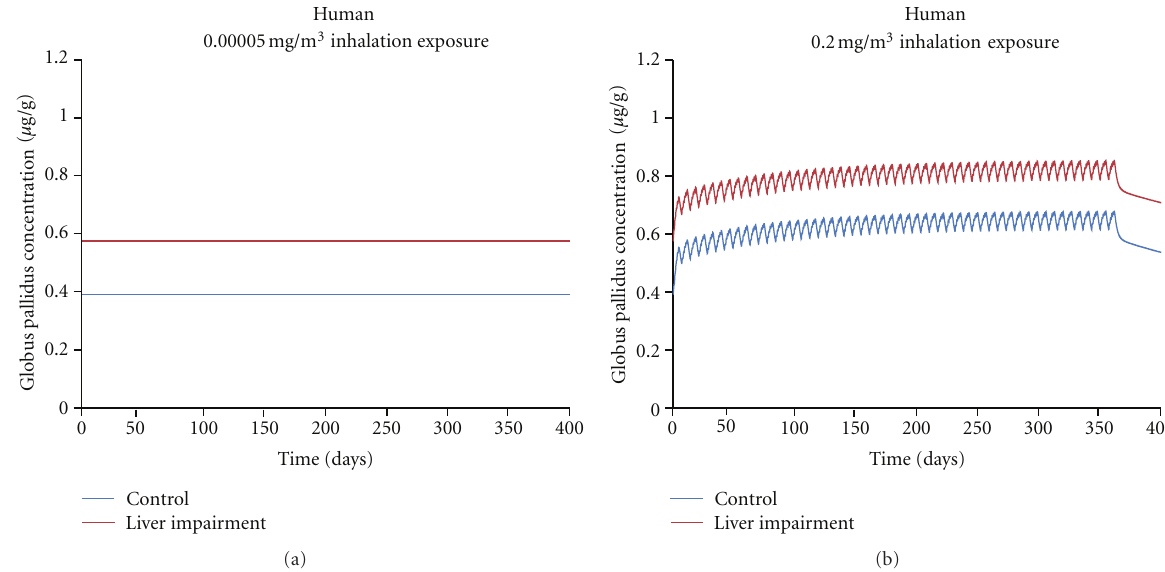
Figure 5: Simulated globus pallidus manganese concentrations in humans following inhalation exposure to MnSO 4 at 0.00005 (a) or 0.2mg (b) Mn/m 3 for 8 hr/d, 5 d/wk, for one year. Simulations were performed using the human model developed by Schroeter et al. [19] with